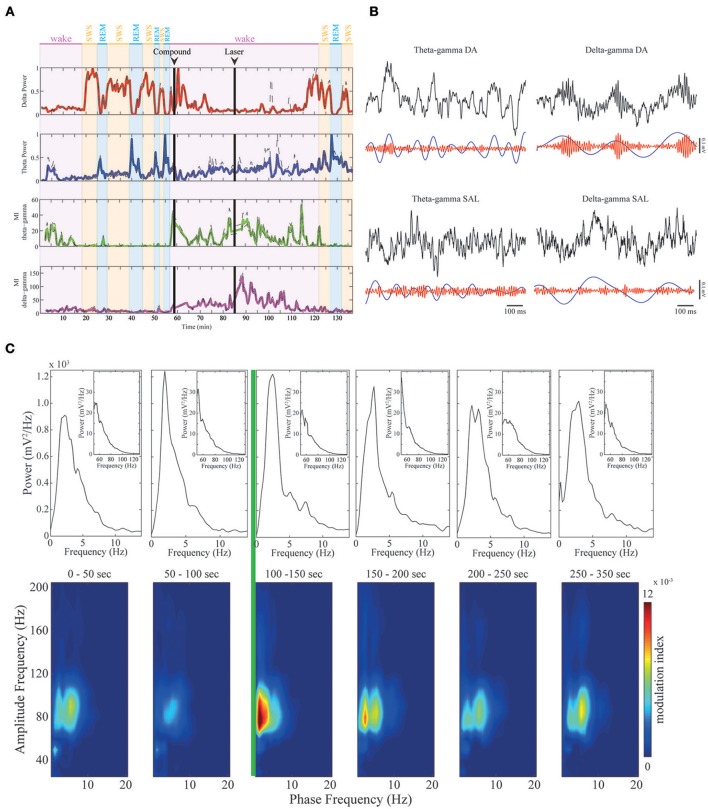
Dopamine modulates CFC in mPFC. (A) Upper panels: delta (red trace) and theta (blue trace) band power across sleep-wake cycles in a representative animal. Delta power is high in SWS, while theta power is high during REM sleep and active WK periods. Lower panels: continuous modulation index during the whole experiment. As shown before, theta-gamma comodulation (green trace) only appears in active wake and is absent during REM sleep, while delta-gamma comodulation (magenta trace) is absent before RuBiDopa injection. After dopamine uncaging, the strength of the delta-gamma comodulation significantly increases, and then it returns to basal values. (B) Examples of raw data for theta-gamma and delta-gamma coupling in the presence of DA (after RuBiDopa uncaging) and in control conditions (after saline injection). In all cases, upper black traces represent 1-s period of recording of raw LFP. Lower traces represent filtered frequency bands. As noticed, in DA condition the amplitude of gamma (red trace) is modulated by the phase of delta (blue trace), with gamma having high amplitude during delta peaks/descending phase. In the others conditions we do not find correlation between gamma amplitude and theta/delta phase. (C) Peri-event Power Spectrum Density plots (PSDs) and comodulograms. Upper panels: power spectra of 50 s-epochs for delta/theta bands (inset: gamma band). Below, six comodulograms for the respective 50 s epochs. The green line represents laser onset, leading to RuBiDopa uncaging.